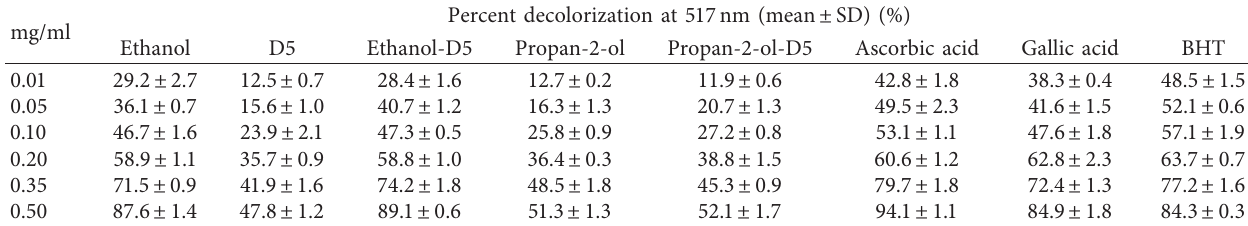
Table 5: Free radical scavenging activity of extracts obtained using various solvents by DPPH method.